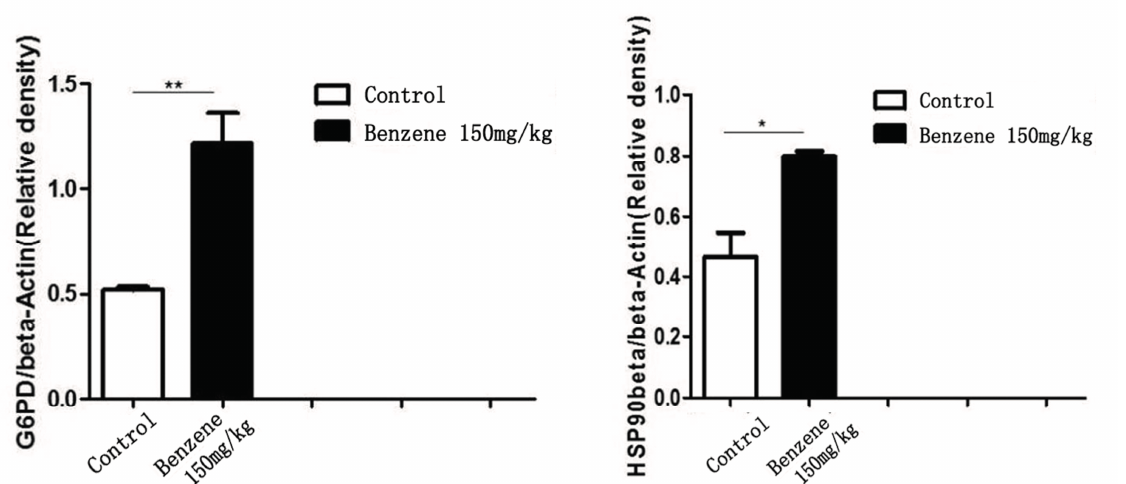
Figure 4. Relative expression (/ β -actin) of G6PD and HSP90 Beta in the liver cells of control mice and benzene-exposed mice. ** p < 0.01 compared with the control group. * p < 0.05 compared with the control